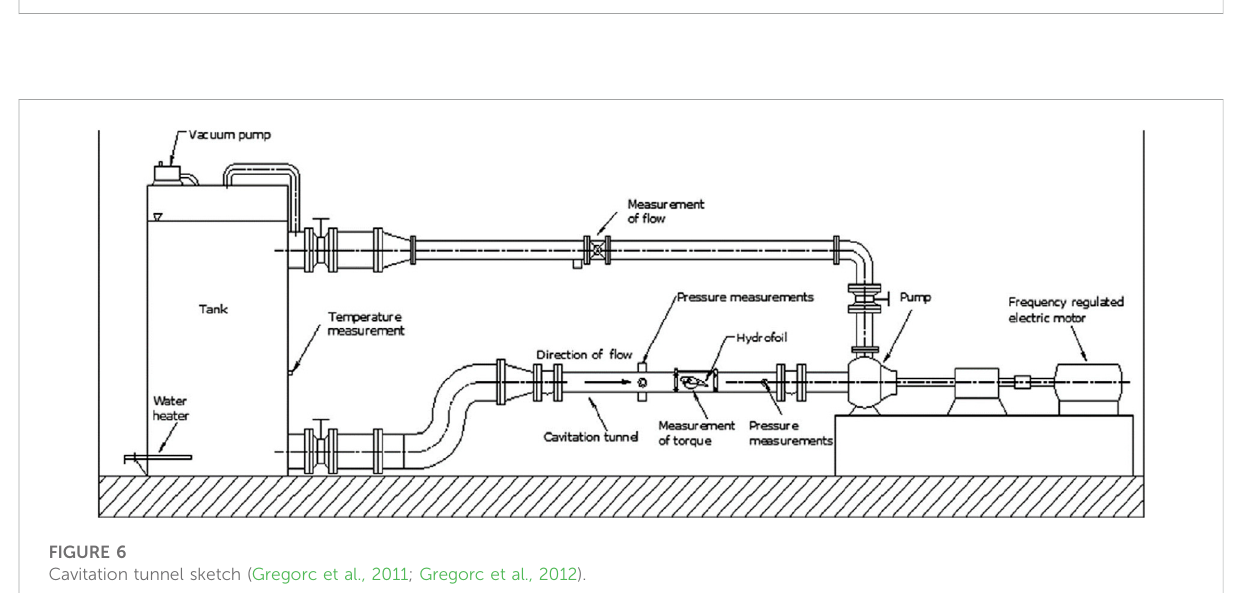
FIGURE 6 Cavitation tunnel sketch (Gregorc et al., 2011; Gregorc et al.,